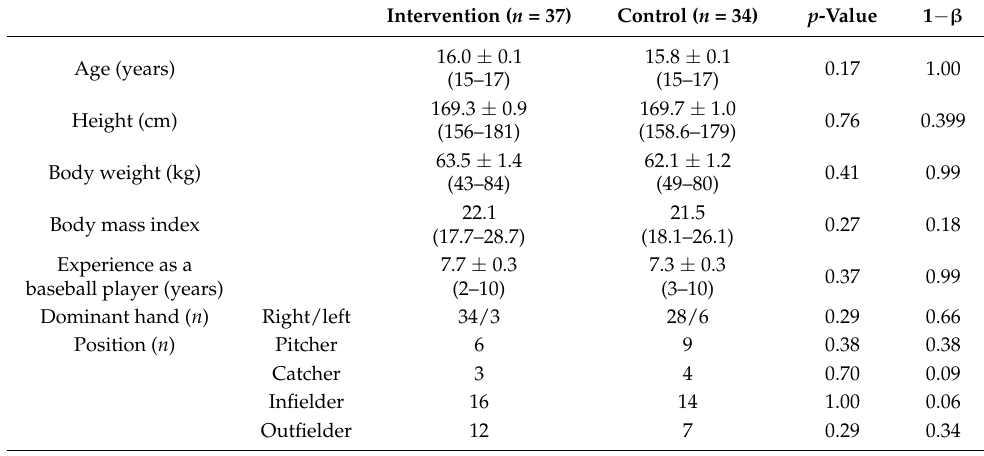
Table 1. Subject characteristics. ( n =